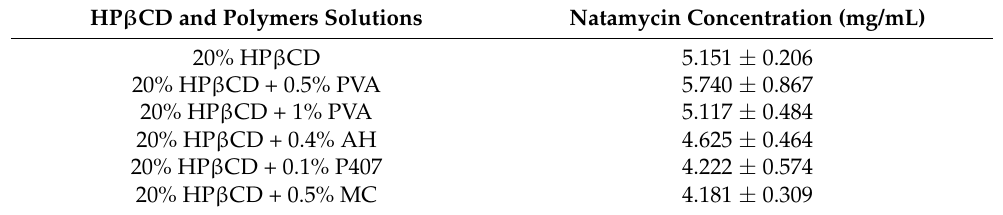
Table 4. Natamycin concentration in presence of 20% ( w / v ) HP β CD and different hydrophilic polymers.